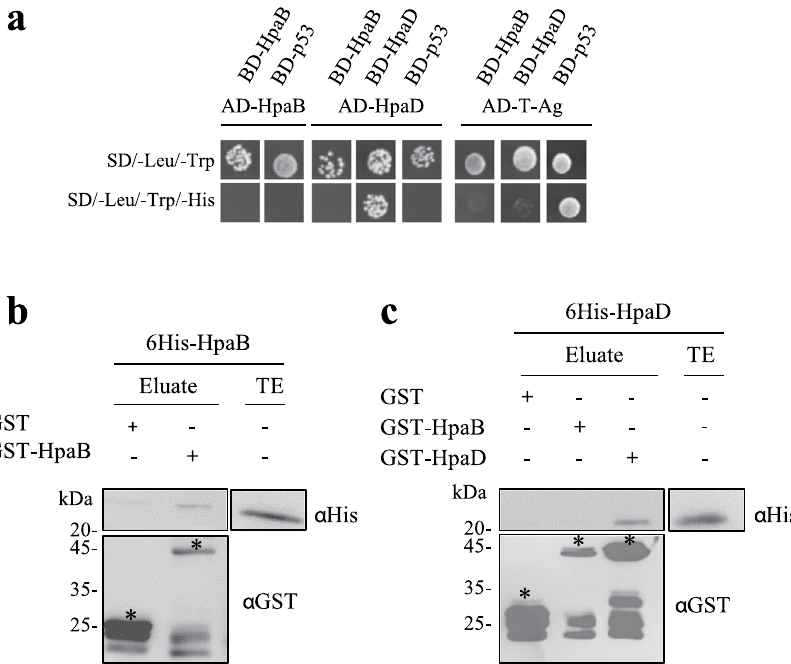
Figure 2. HpaB and HpaD self-interact but do not interact with each other. ( a ) Yeast cells were co-transformed by BD-HpaB or BD-HpaD and AD-HpaB or AD-HpaD. Double transformation and interaction were tested by plating yeasts on synthetic dropout medium lacking leucine and tryptophan (SD/–Leu/–Trp) and synthetic dropout medium lacking leucine, tryptophan and histidine (SD/–Leu/–Trp/–His), respectively. BD-p53 and AD-T-antigen were used as controls, together as a positive control (BD-p53/AD-T-Ag interaction is visualized with a yeast growth on minimal medium lacking histidine) and for tested interactors as negative controls. ( b ) Glutathione S-transferase (GST), GST-HpaB or GST-HpaD were immobilized on glutathione sepharose and incubated with an E . coli lysate containing 6His-HpaB or 6His-HpaD. Total cell lysates and eluted proteins were analysed using antibodies directed against GST and the 6His epitope. Bands corresponding to GST and GST fusion proteins are marked by asterisks. Lower bands represent degradation products. Two biological replicates were performed for ( a ) and ( b ) with similar